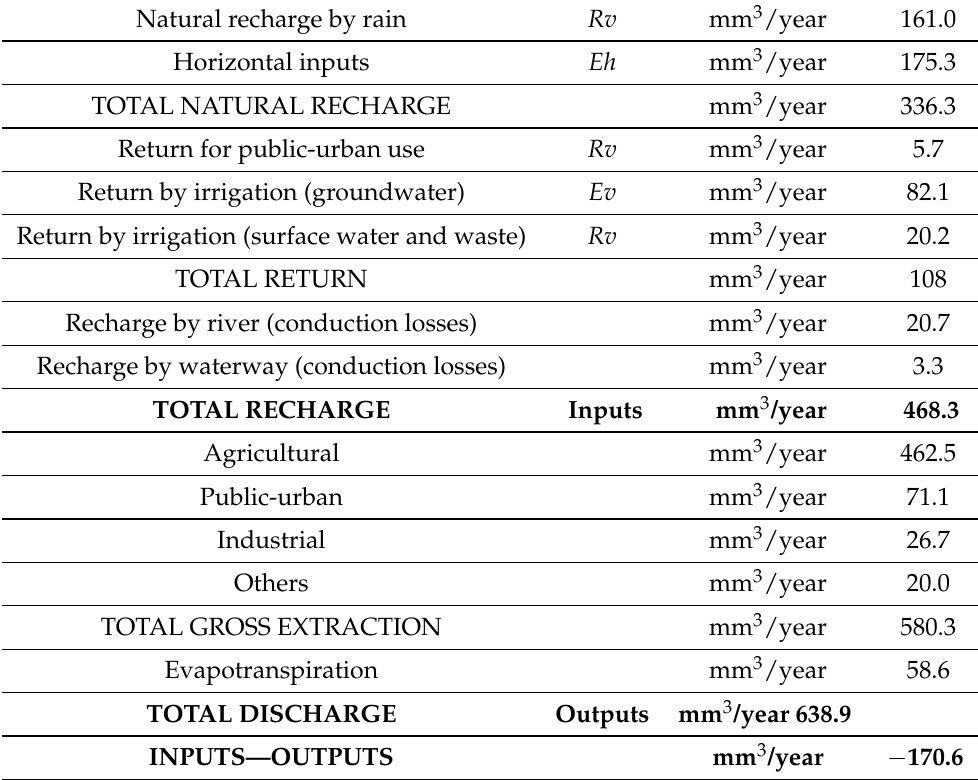
Table 1. Variables for calculating the groundwater balance in the Valle de Celaya aquifer in the dry